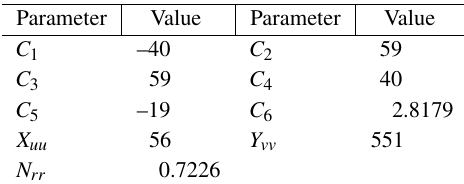
Table 4. Values of the parameters for U-CAT model Parameter Value